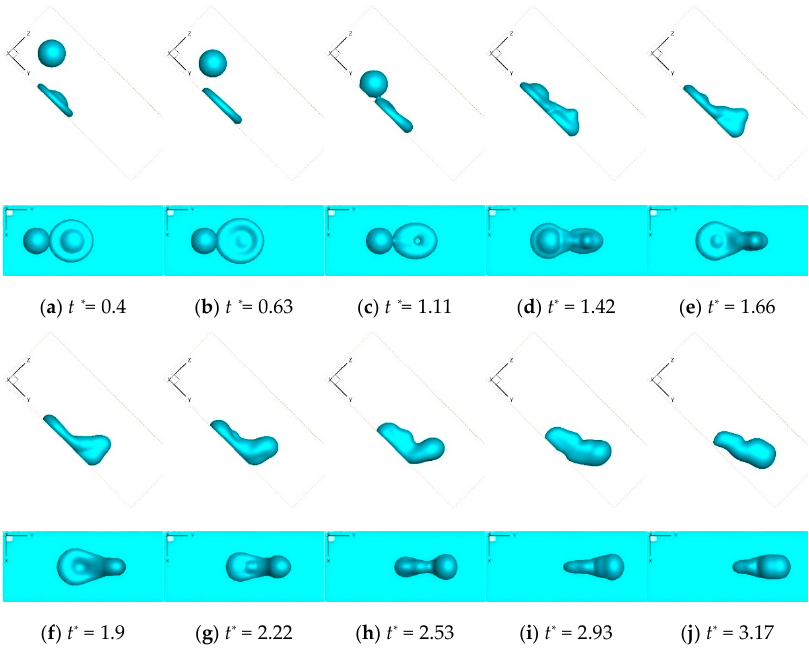
Figure 3. Snapshots of two successive droplets impacting an inclined superhydrophobic surface at v r = 0.7 and L z * = 1.18.